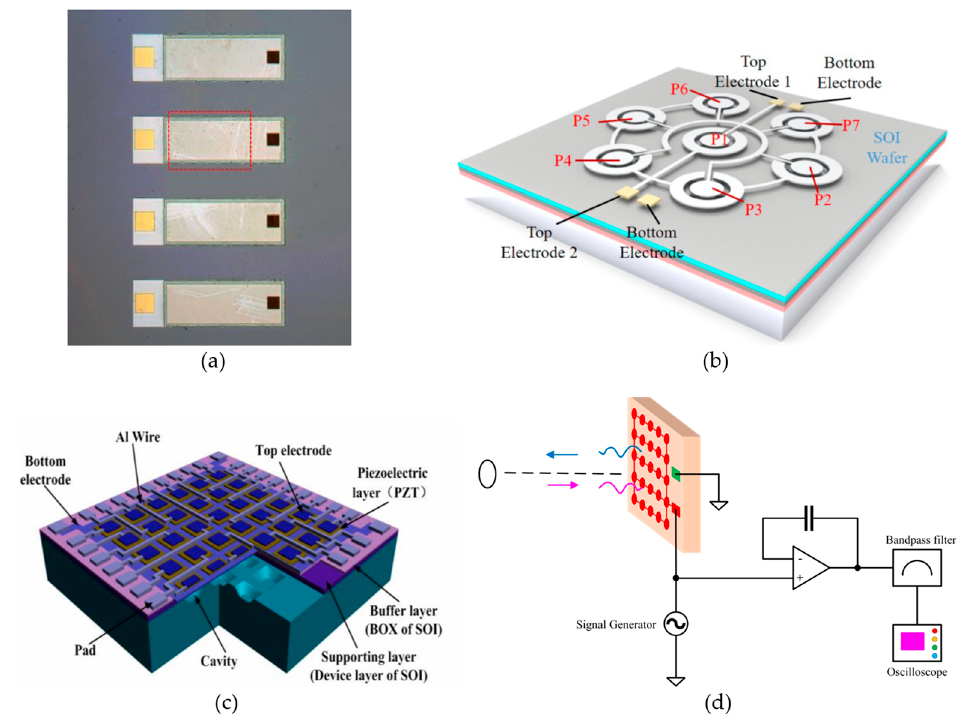
Figure 7. ( a ) A 1D pMUT array. Reproduced with permission from [61] , Copyright 2016, IEEE. ( b ) A hexagonal pMUT array. Reproduced with permission from [62] , Copyright 2021, IEEE. ( c ) A 2D square array. Reproduced with permission from [23], Copyright 2013, MDPI AG. ( d ) A pMUT rangefinder system using a pMUT